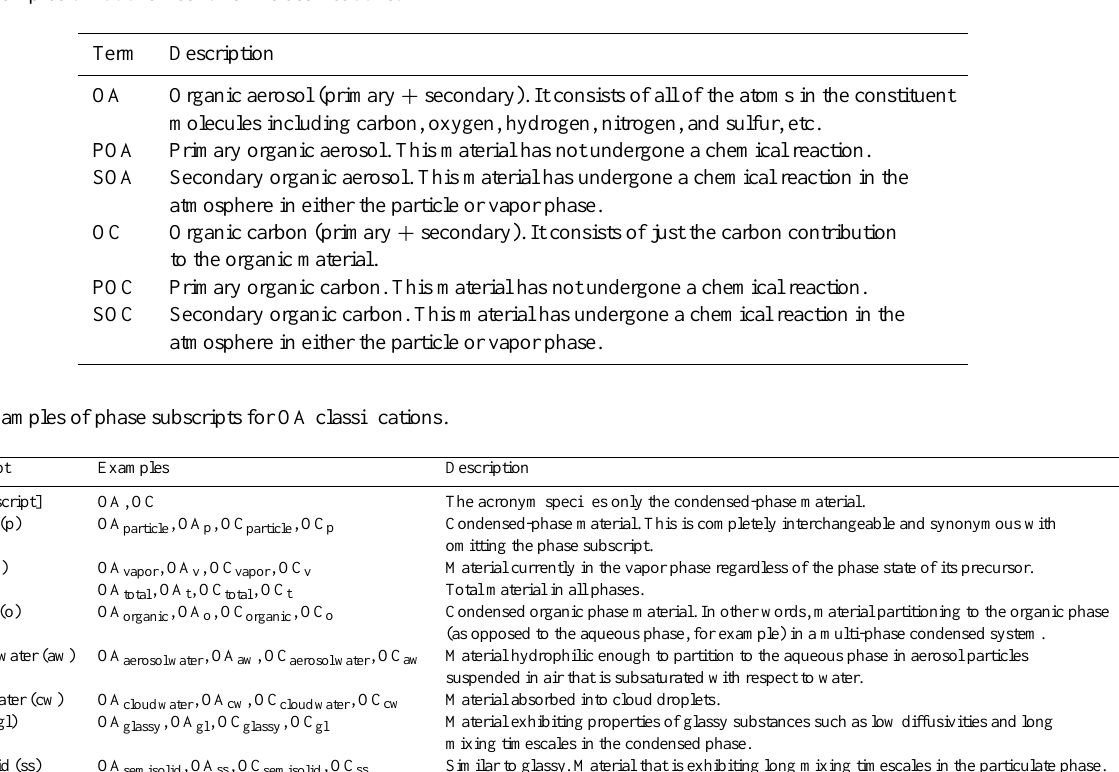
Table 1. Examples of root names for OA classifications.